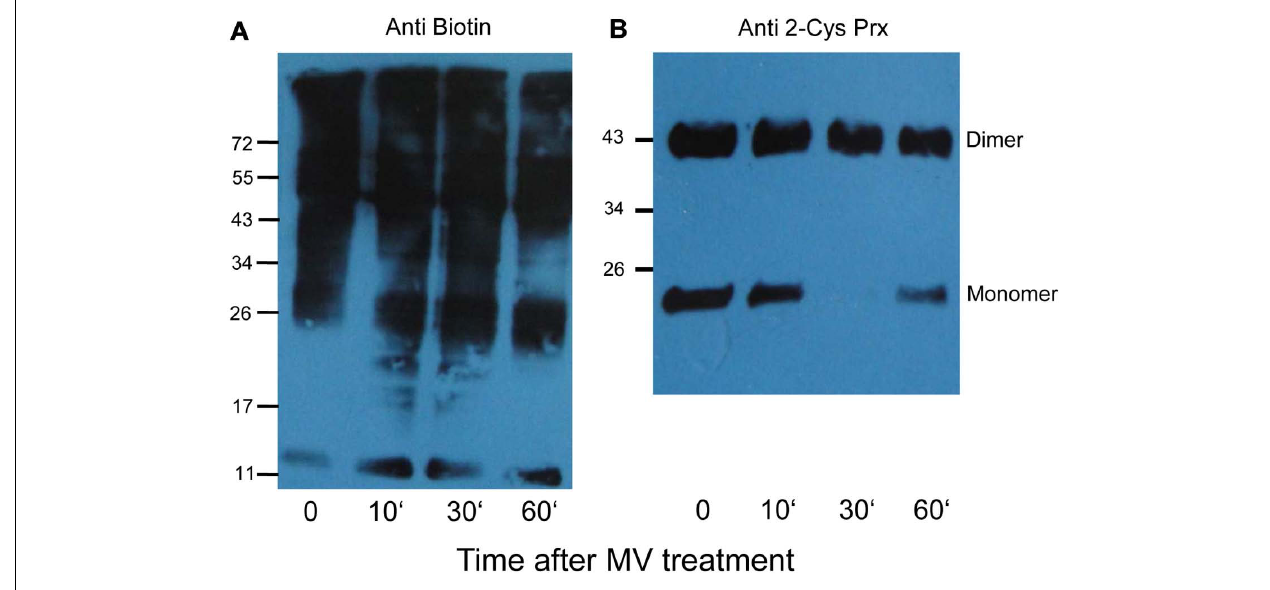
FIGURE 6 | Biotinylated proteins from A. thaliana leaves after methyl viologen treatment. (A) The immunoblot shows increased labeling in protein extracts after treating plants with 50 μ M MV for different time periods. Control plants (0) were sprayed with water. All samples were extracted in the